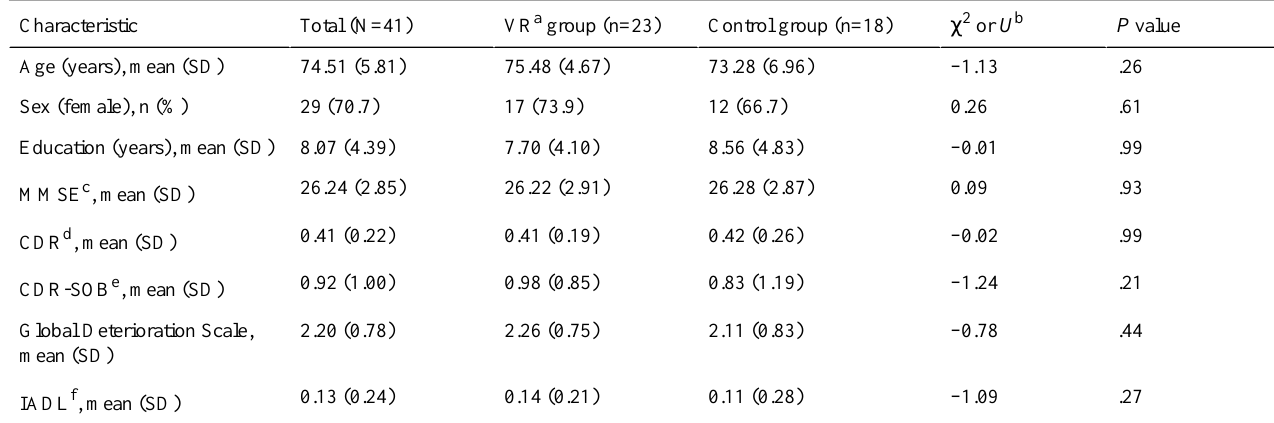
Table 1. Demographic and clinical characteristics of all study participants.